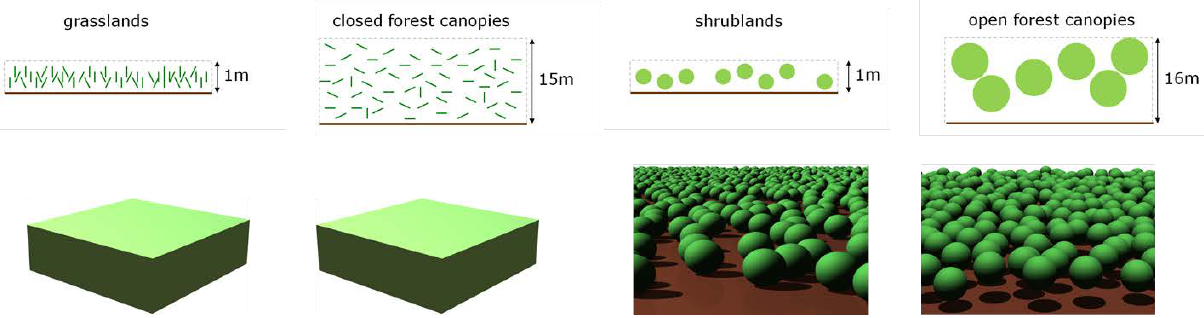
Fig. 2. Schematic depictions of RAMI4PILPS scenes: closed forest canopies, grasslands, 3-D shrublands and 3-D open forest canopies (left to